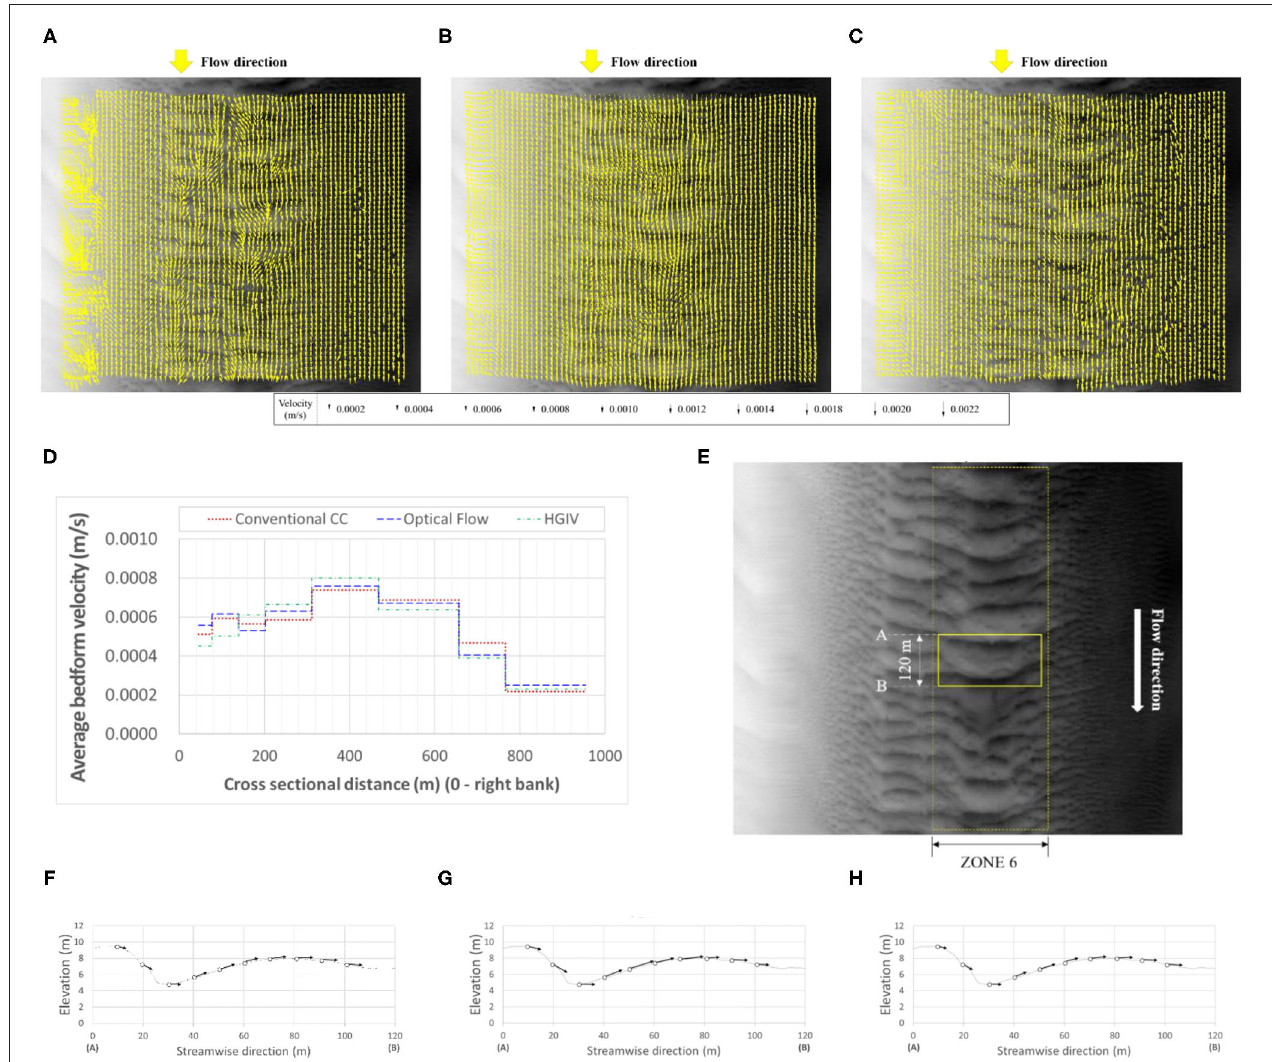
FIGURE 8 | Comparison of various IV approaches used in conjunction with AMV: (A–C) bedform velocity spatial distribution over the surveyed area obtained with CCM, OFM, and HGPIV, respectively; (D) comparison of the cross sectional average bedform velocities obtained with the three IV approaches; (E) area of detailed observation within the acoustic map; (F–H) distribution of the averaged velocity at the surface of the bedform enclosed in the area shown in this figure (E)